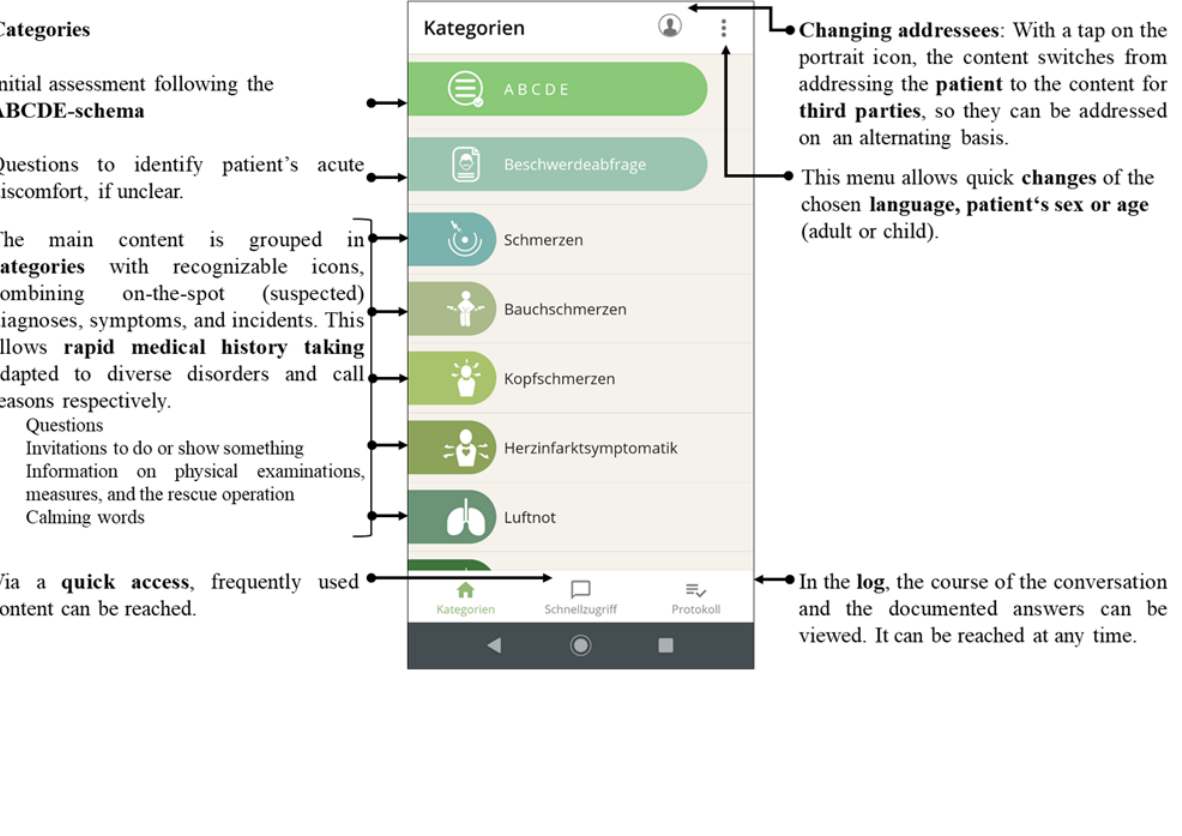
Figure 3. Main functions of the app and structure (categories; see text for further